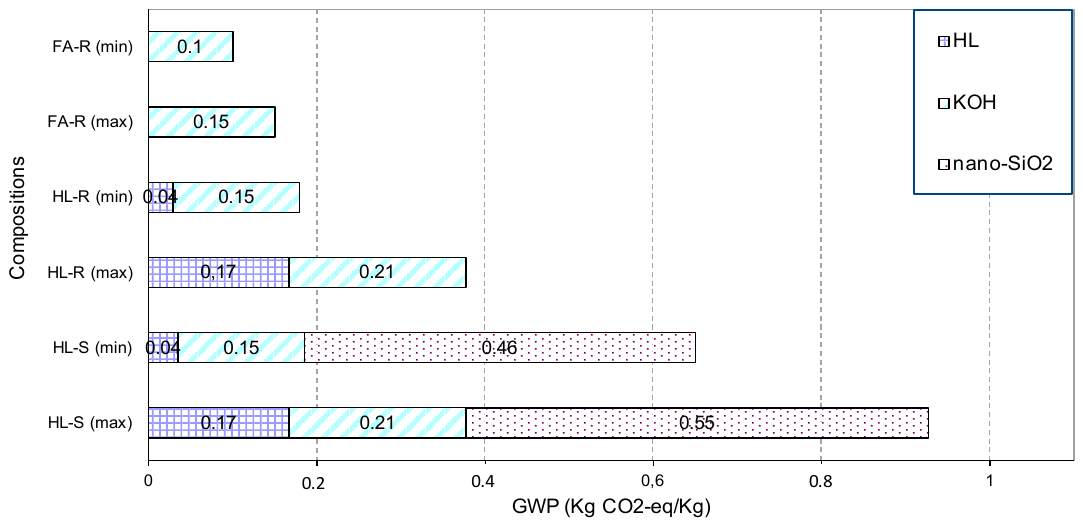
Figure 11. Distribution of GWP for each component of the three compositions, considering the minimum and maximum values found in the literature.